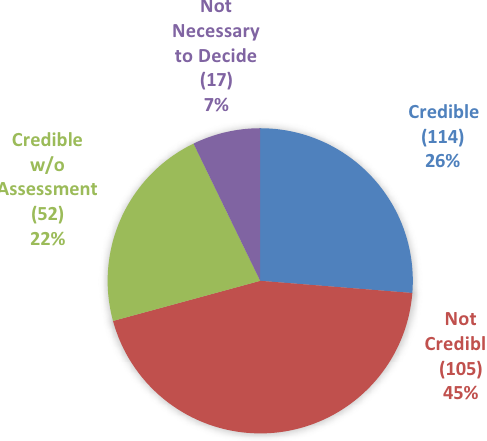
Figure 5. Results of Credibility Assessment.